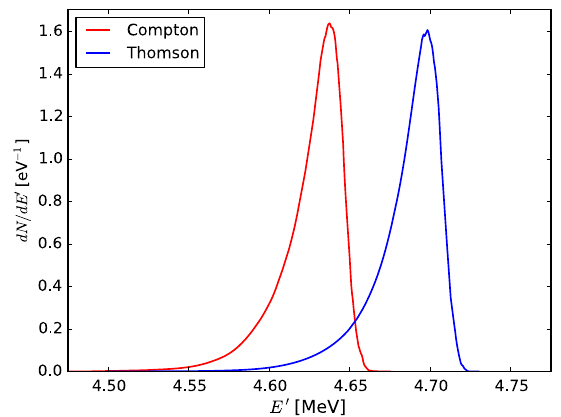
FIG. 8. Spectra — in both the Compton and Thomson regimes — for the ELI project, with parameters given in Table III. A total of 10 000 particles were used in generating this